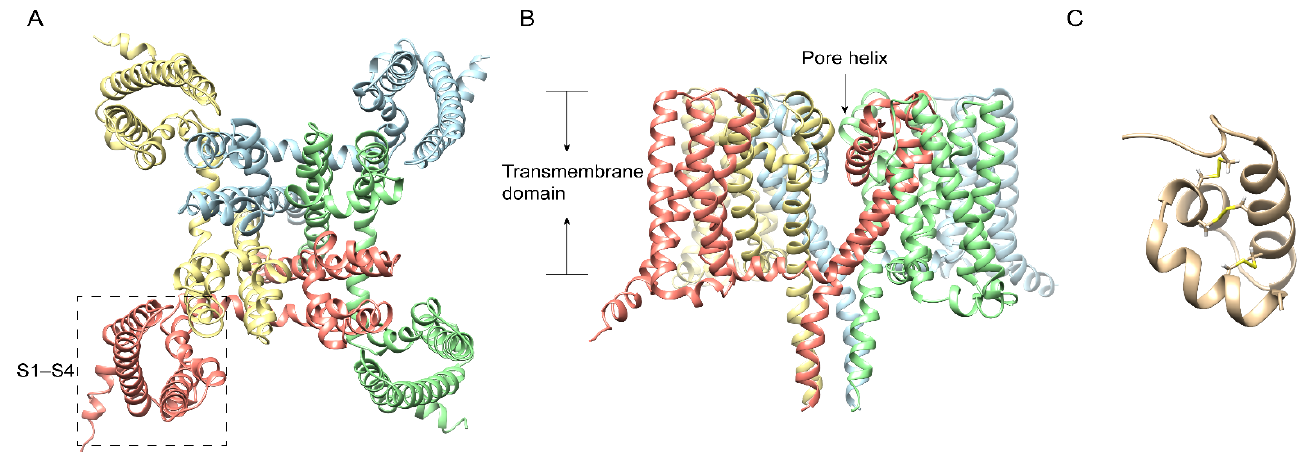
Figure 1. Ribbon diagram of human Na V 1.7 atomic model (PDB id: 5EK0) with each of the four subunits color-coded, showing views from the bottom ( A ) and side ( B ). The voltage-sensing domain is labeled with a dashed box. The membrane-spanning helices and different subunits of Na V 1.7 channel are indicated. ( C ): μ -SLPTX-Ssm6a from the Chinese red-headed centipede Scolopendra subspinipes . PDB id: 2MUN.